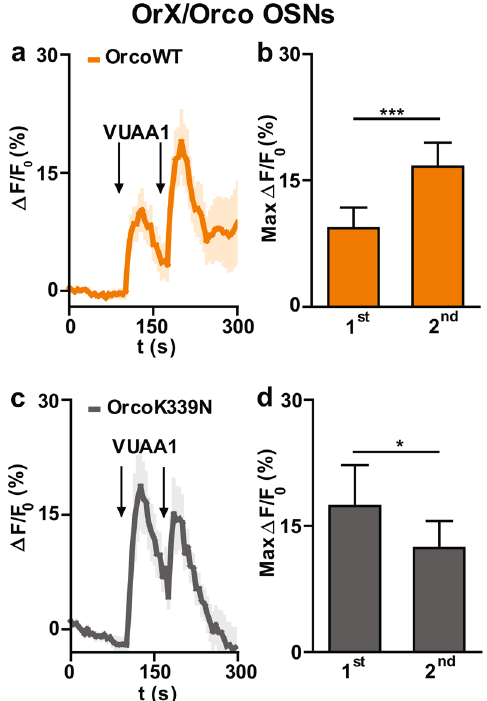
Figure 4. Effect of Orco CBS mutation on the sensitization in OrX/Orco expressing OSNs. ( a,c ) Time course of Ca 2+ fluorescence response (∆F/F 0 (%)) in OrX/OrcoWT (a) and OrX/OrcoK339N (c) OSNs upon ORs stimulation with 3 µM VUAA1 stimulation (n = 16 for OrcoWT, and n = 9 for OrcoK339N). (b , d) intensity of 1st (first) and 2nd (second) Ca 2+ fluorescence responses (∆F/F 0 (%)) for OrcoWT (b) and OrcoK339N (d) . Intensity of 1st and 2nd response was calculated by subtracting the base level from the maximum Ca 2+ fluorescence. In case of sensitization, the 2nd response is significantly higher than 1st response. n = cell bodies. Two-tailed paired t- test, * P < 0.05, *** P < 0.001. Data given as mean ±